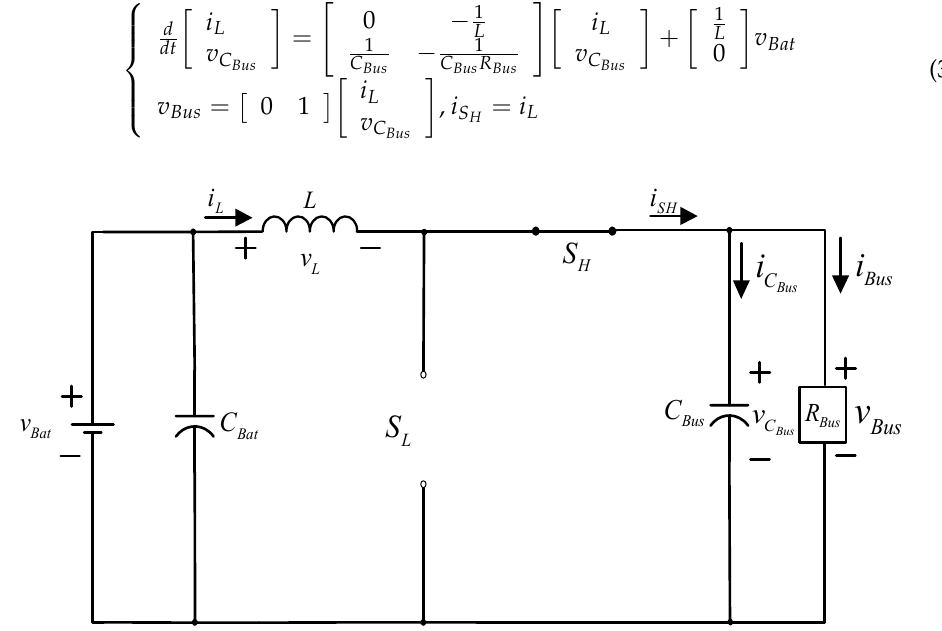
Figure 5. The equivalent circuit of the bidirectional buck–boost converter when the low-voltage side switch S L is in a cut-off state and the high-voltage side switch S H is conducting.